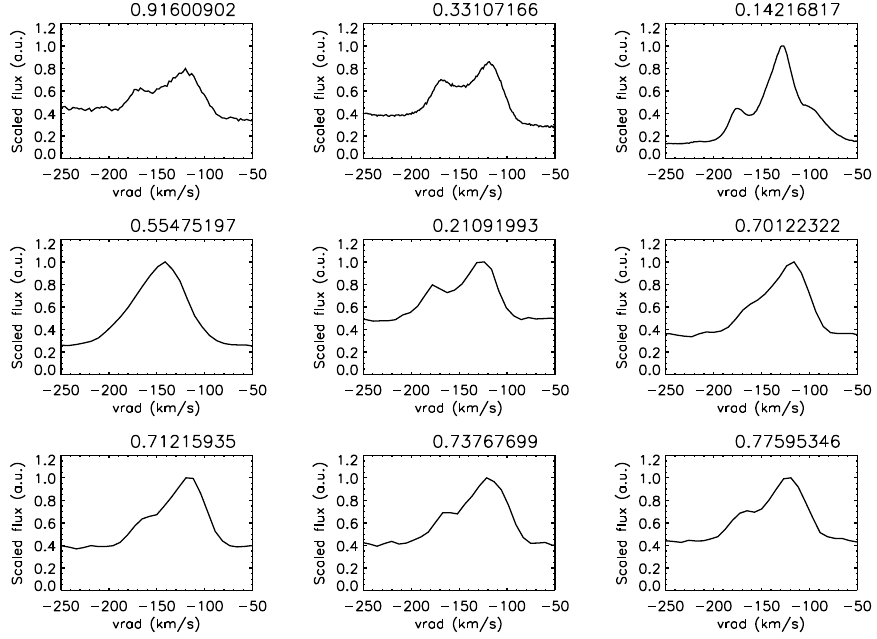
Fig. 6a. Examples of the He I 5875 ˚A line profiles in AG Dra as a function of orbital phase from Catania, TNG and Asiago spectra. The dispersions were 0.02 ˚A px (cid:0) 1 and 0.15 ˚A px (cid:0) 1 . The time period is from JD 51826 to JD 55076 covering eight orbits.